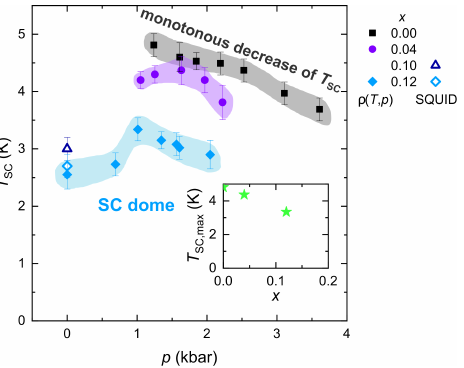
Figure 6. Superconducting transition temperature T SC for κ -[(BEDT-TTF) 1 − x (BEDT-STF) x ] 2 Cu 2 (CN) 3 with x = 0.00, 0.04, and 0.12 as a function of pressure. In addition to the results from DC transport ρ ( T , p ) (solid symbols; see Figure 5), the open symbols indicate the ambient pressure magnetization data points at x = 0.10 and x = 0.12 (see Figure 4). While the parent compound ( x = 0.00) exhibits a monotonous suppression of the superconducting transition temperature with p , a dome-like structure develops for x = 0.04 and 0.12. The shaded areas following the trend of T SC in the respective colors are guides to the eye. The inset illustrates the reduction of the maximum value of T SC upon chemical substitution x